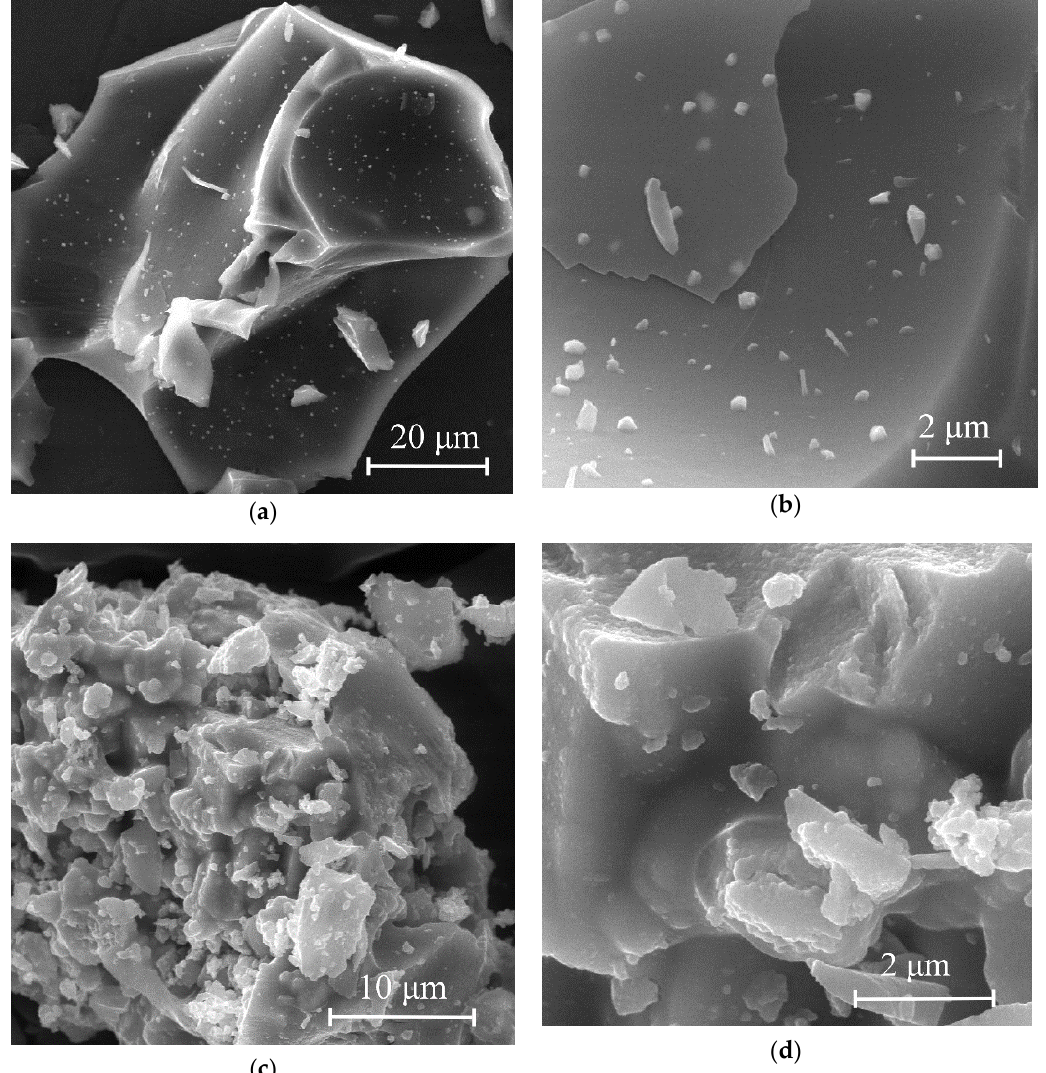
Figure 7. Micrographs of Mo 2 C obtained by heat treatment of a molybdenum blue xerogel synthesized using ( a , b ) glucose (G-5, R/Mo = 5) and ( c,d ) hydroquinone (H-4, R/Mo = 4).